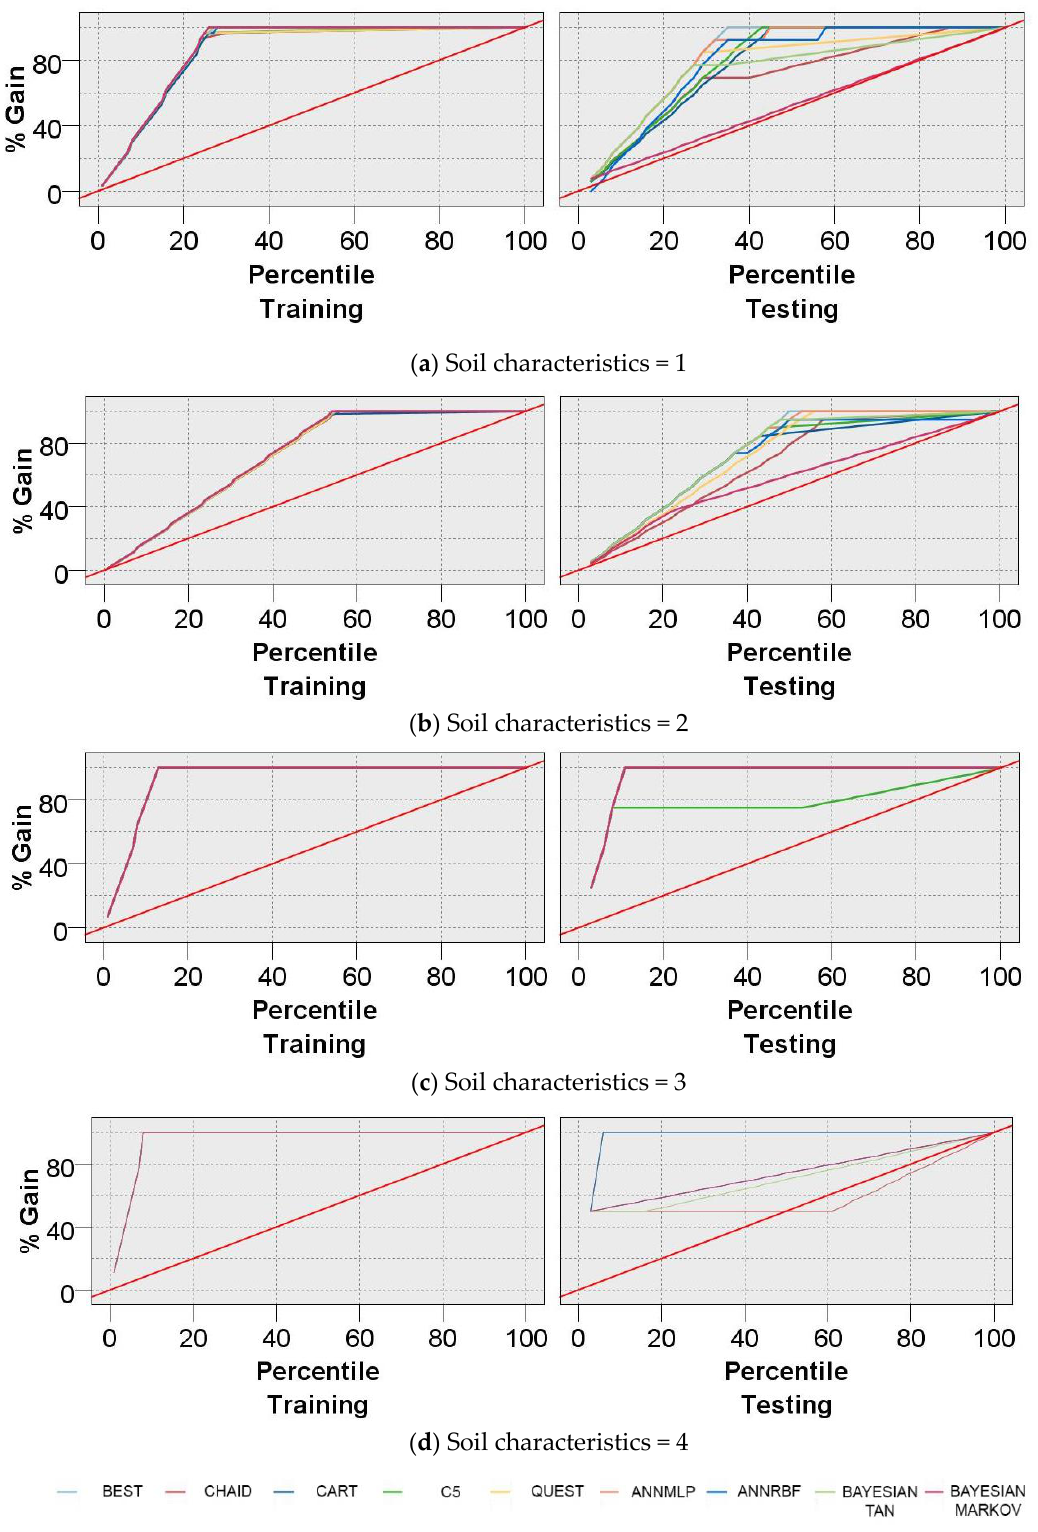
Figure 12. Gain chart of the models employed.